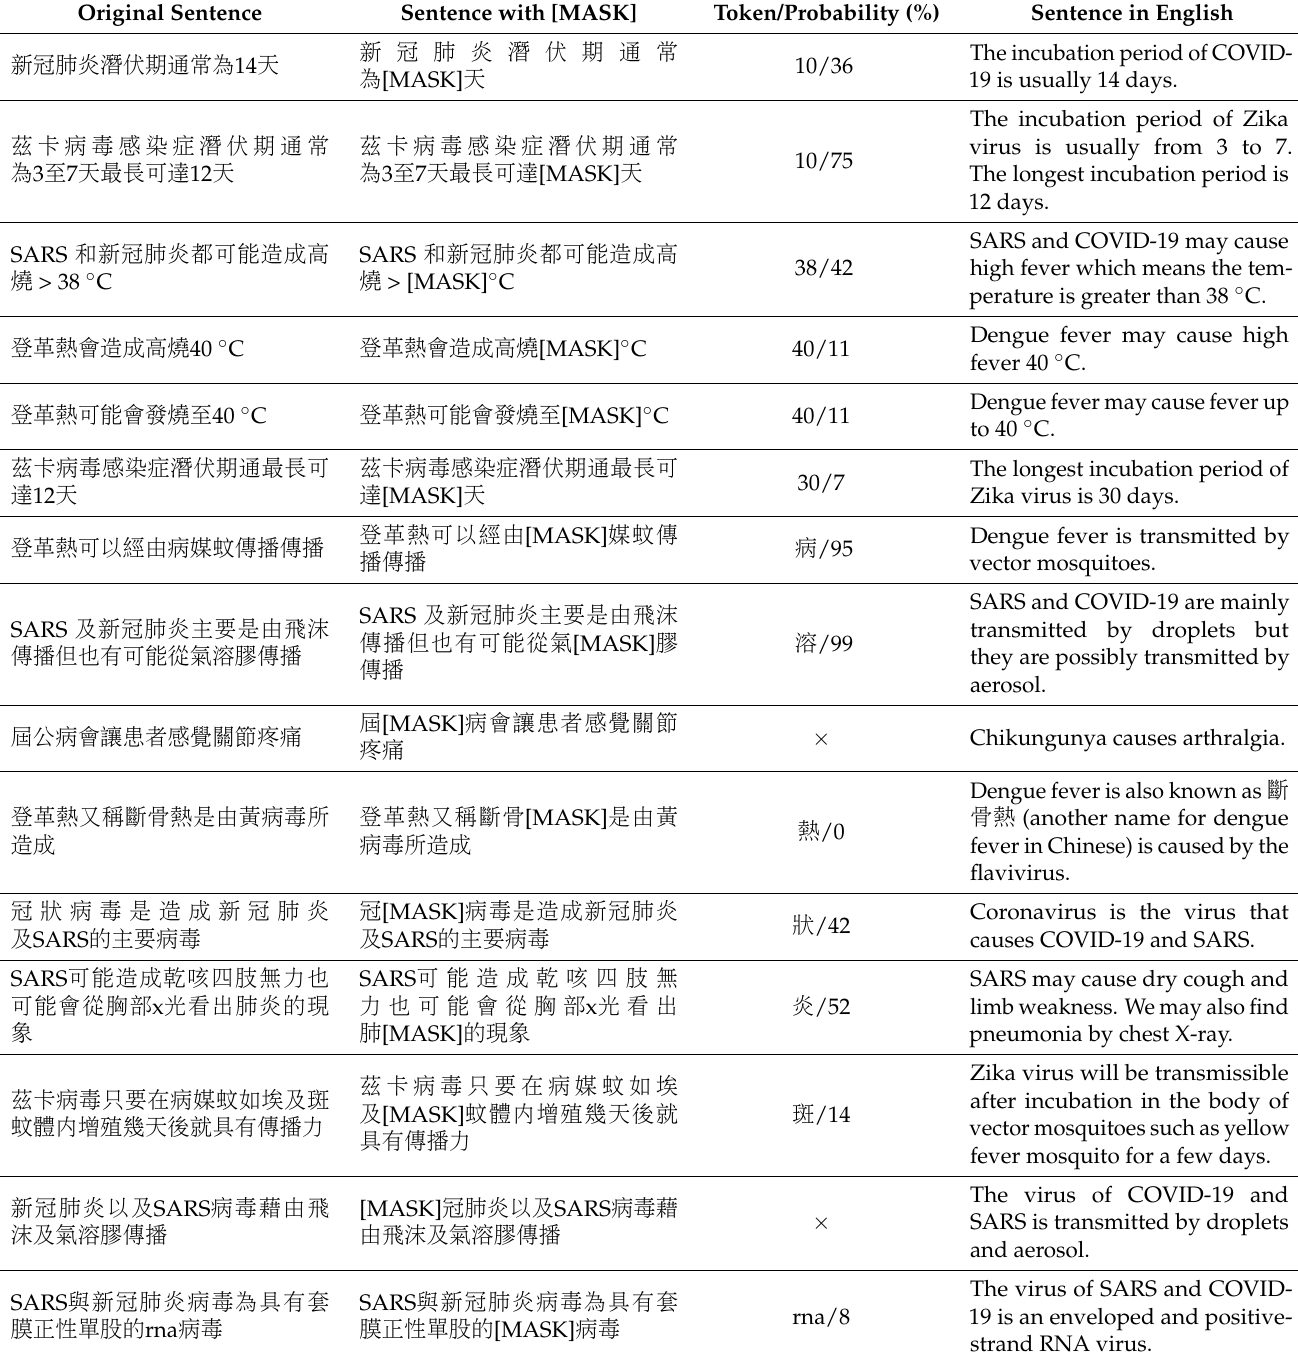
Table 7. Results of the BERT Model without special